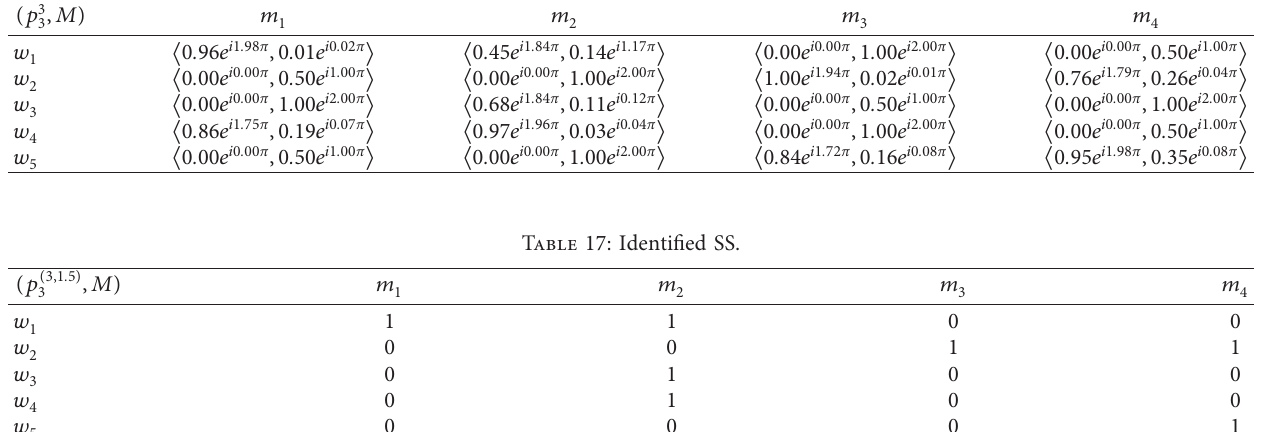
Table 16: Identified C